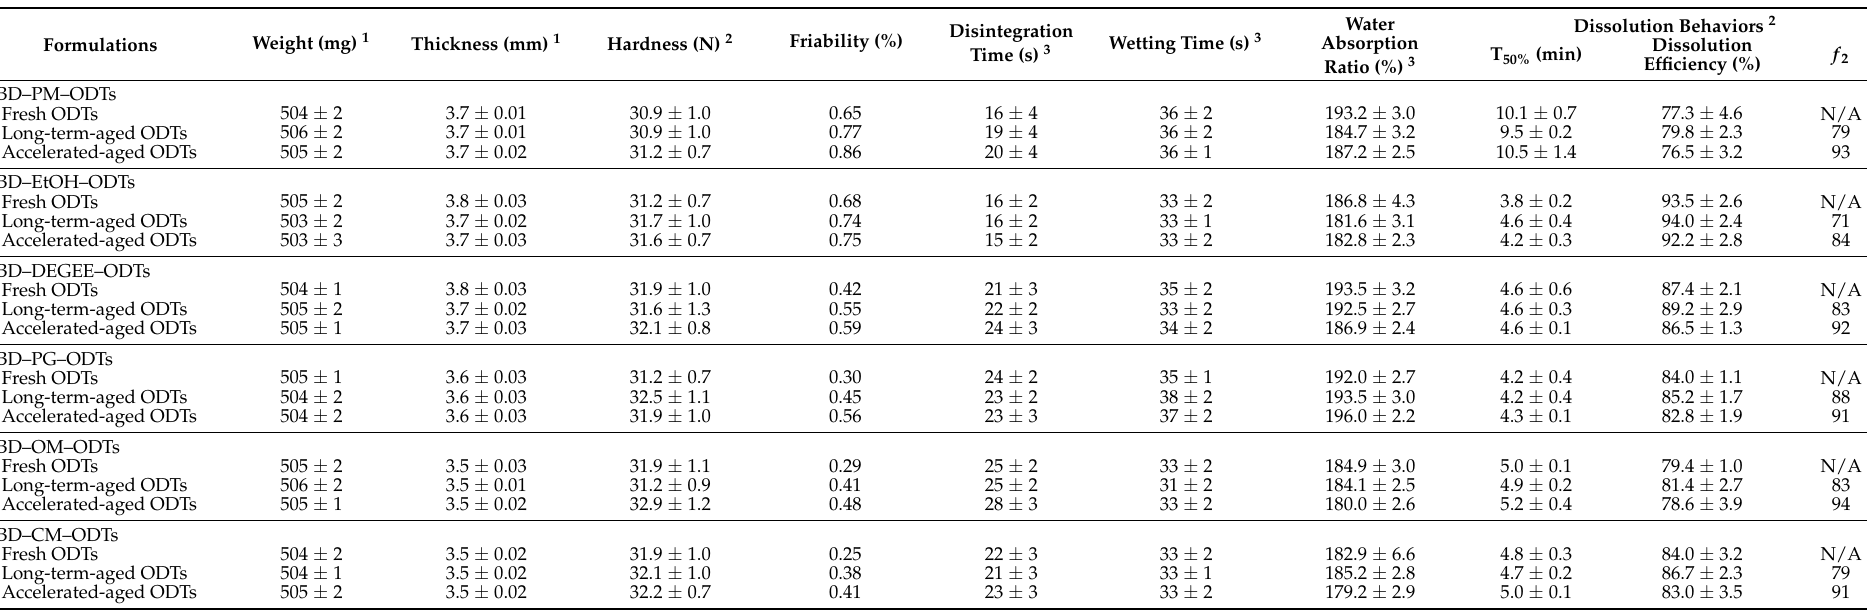
Table 5. Tablet properties of 4-month-old CBD ODTs stored at 5 ± 3 ◦ C (long-term) and 30 ± 2 ◦ C/75 ± 5% RH (accelerated) conditions compared with fresh